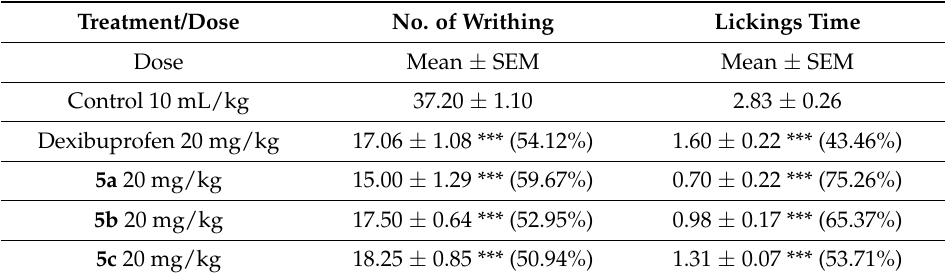
Table 3. Effect of prodrugs ( 5a – c ) against acetic acid induced writhing and formalin induced licking in mice.